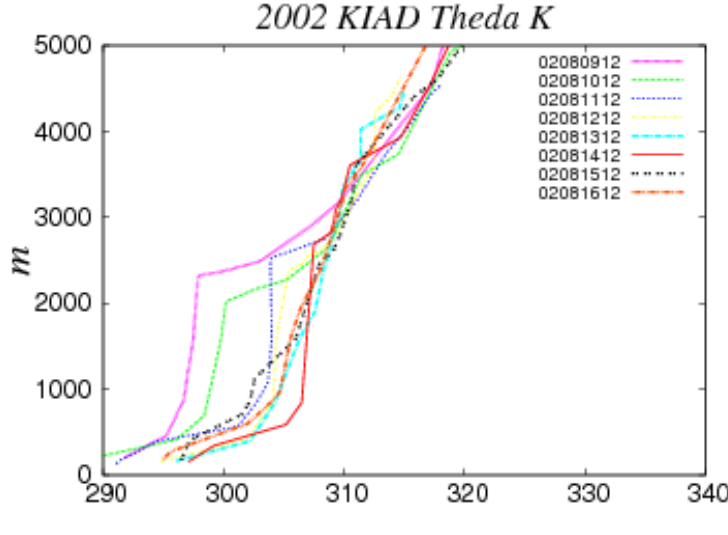
Figure 3. Potential temperature (Theda: θ) vertical profile at KIAD from 9–16 August 2002. X-axis is θ values; Y-axis is height in meter